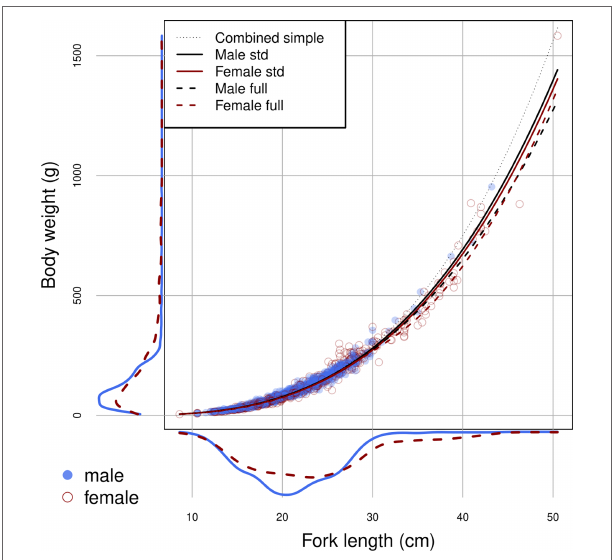
FIGURE 2 | Size distributions in length and weight, and the estimated relationships by sex using the full model (dotted lines) and the standard model (unbroken lines), for brushtooth lizardfish off Taiwan. Lines are based on the means of the source effects and source-date random